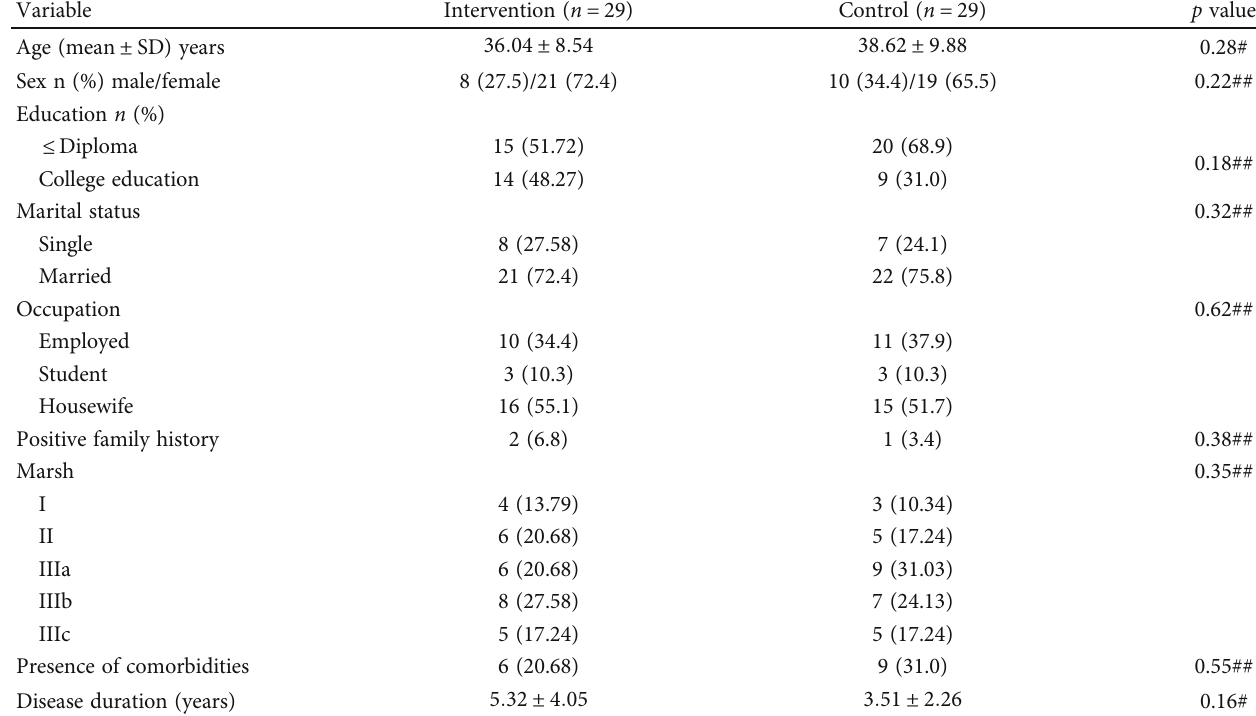
Table 1: The baseline characteristics of participants strati fi ed by